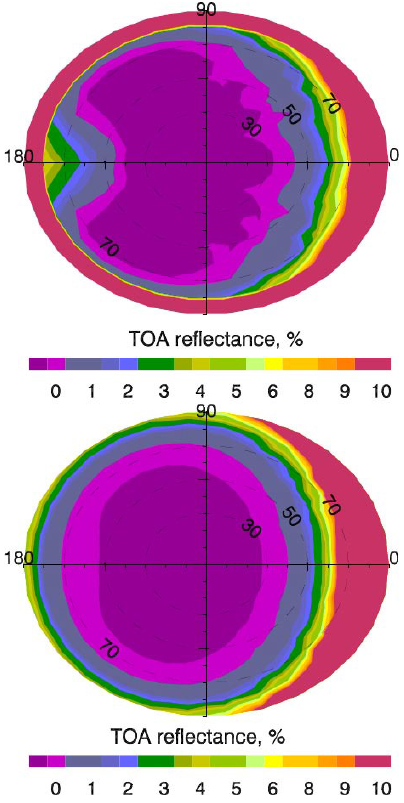
Fig. 4. Angular behavior of aerosol reflectance for accumulation mode of dust aerosol component 550nm (upper panel) and at 3.7µm (lower panel). Sun zenith angle is equal to 65 degrees,